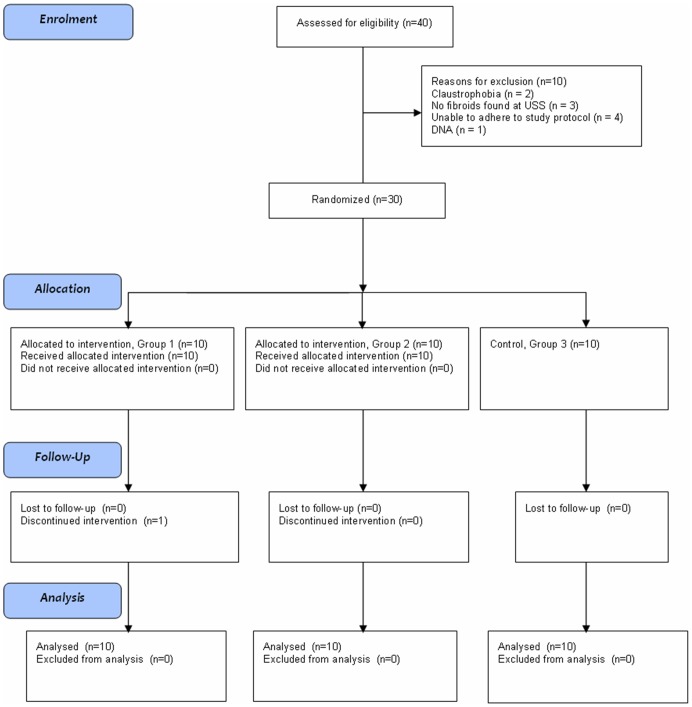
CONSORT flow diagram showing enrolment and progress of study participants.